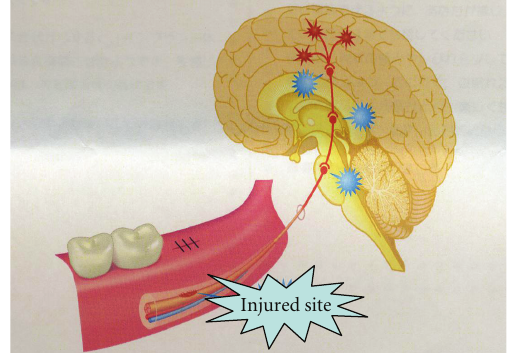
Figure 4: Influence of nerve injury on all neurons